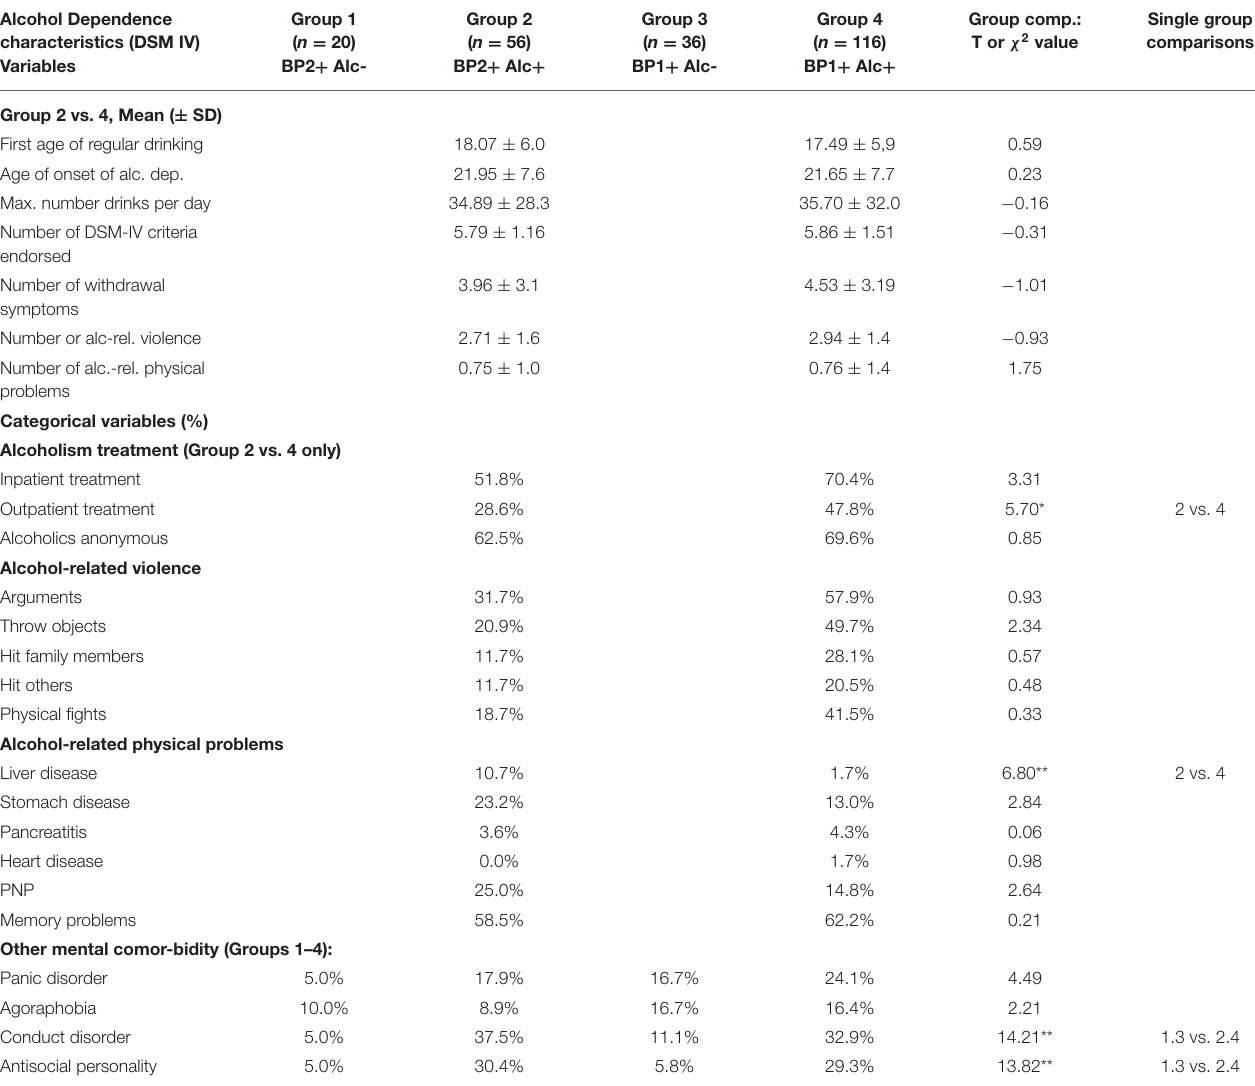
TABLE 2 | Baseline Alcohol dependence-related characteristics and treatment histories of Bipolar 1 and 2 Subjects Divided by Alcohol Dependence Diagnosis. Alcohol Dependence characteristics (DSM